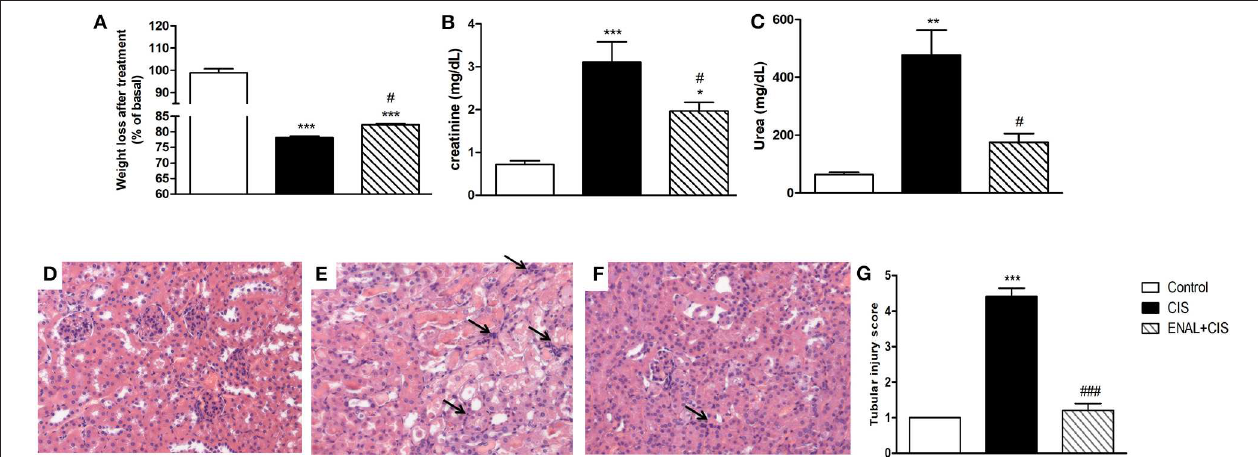
FIGURE 1 | Effect of enalapril treatment in renal injury and function. Male mice were treated with cisplatin (CIS) or cisplatin plus enalapril (ENAL + CIS). (A) After 4 days all cisplatin-treated groups had weight loss; Both serum creatinine and urea levels were reduced by enalapril treatment compared to CIS group. (B,C) Tubular injury score analyzed by histology was smaller in ENAL + CIS group compared to CIS group (D–G) . (D) Control (E) CIS (F) ENAL + CIS. Arrows indicates inflammatory infiltration * p < 0.05, ** p < 0.01, *** p < 0.001. compared to the control group. # p < 0.05; ### p < 0.001. compared to the CIS group. Data presented as Mean ± SEM n =